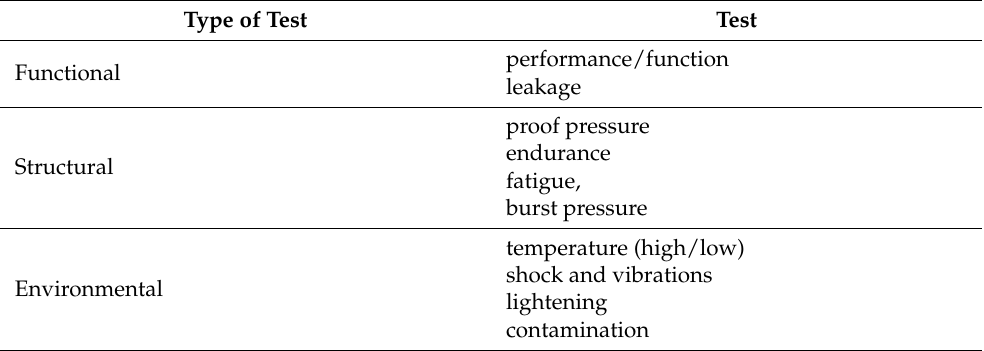
Figure 2. Design optimization flowchart. Table 2. Qualification matrix.